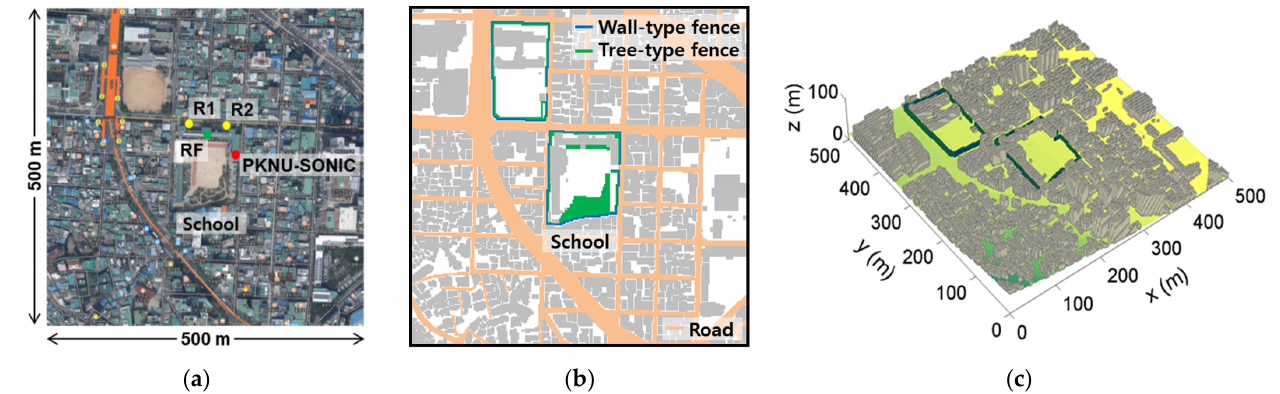
Figure 1. ( a ) Satellite image, ( b ) fence location, and ( c ) computational configurations of the target area.